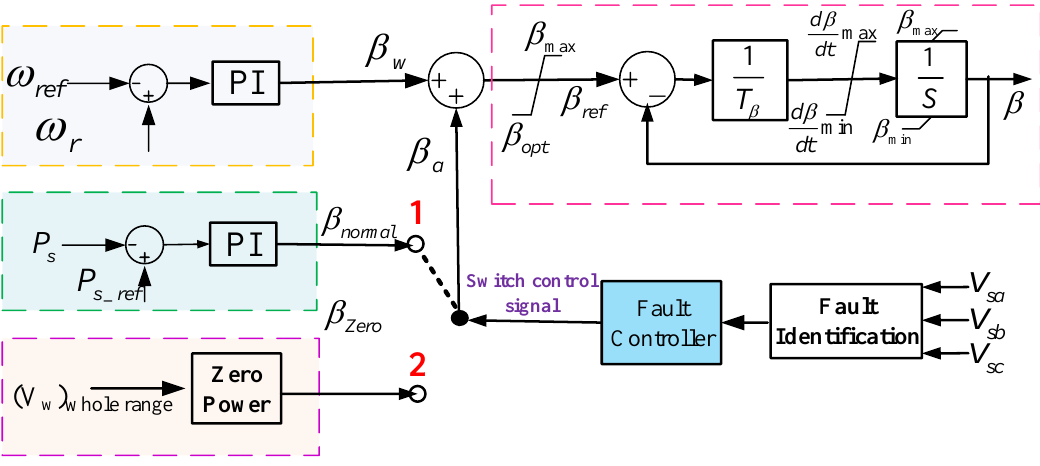
Figure 10. Improved pitch angle controller.